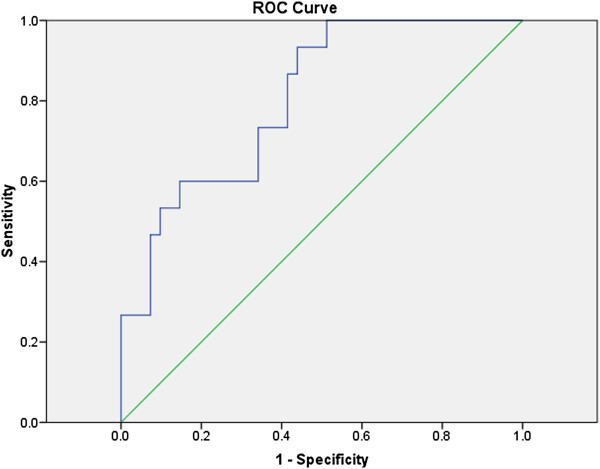
Platelet count for diagnosis of AH. The area under the ROC curve is shown for the performance of the Platelet Count for discriminating AH from no AH diagnosis.